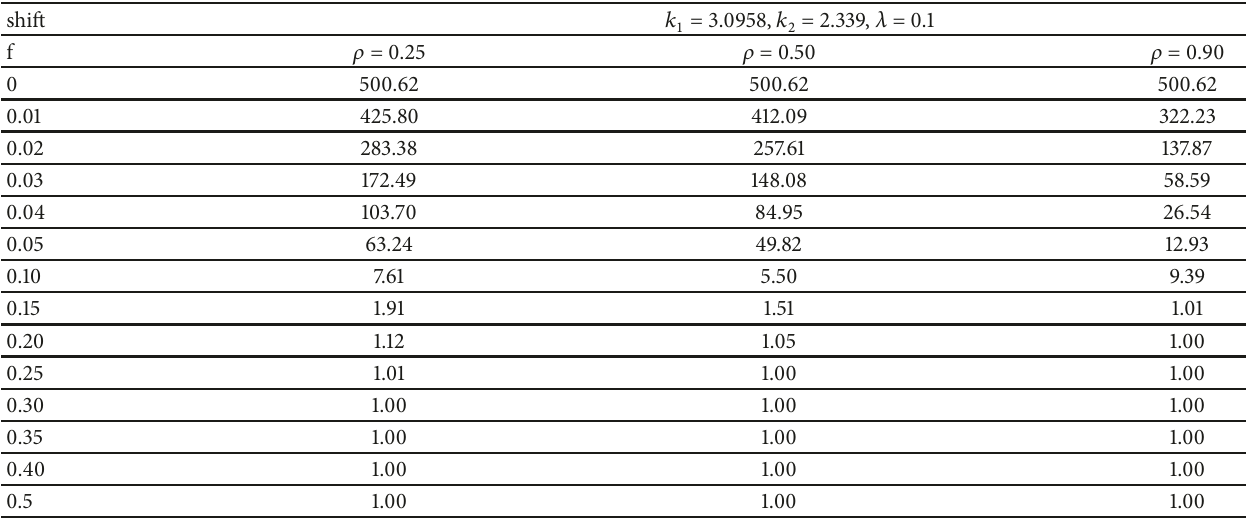
Table 1: ARLs for proposed repetitive EWMA-RSS control chart using Bahl and Tuteja (1991) exponential ratio-type estimator, when 𝑟 𝑜 is 500.